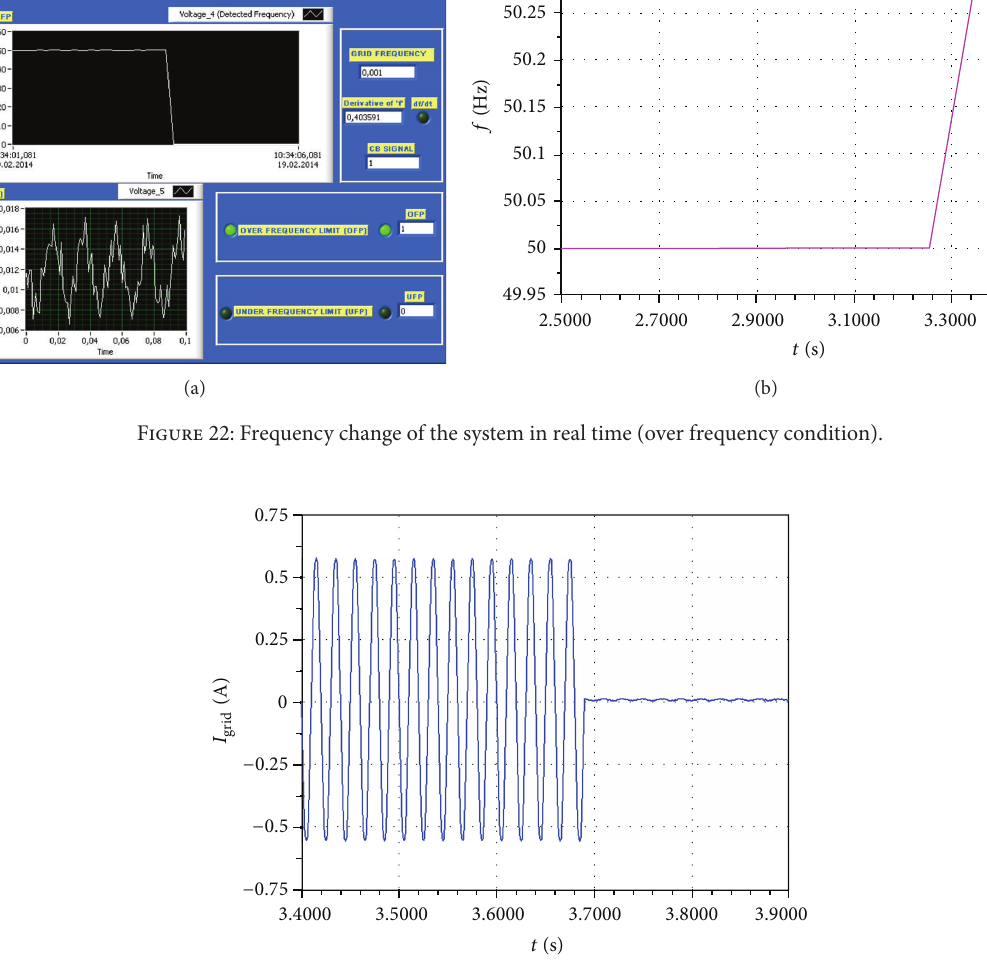
Figure 23: Grid current change for over frequency